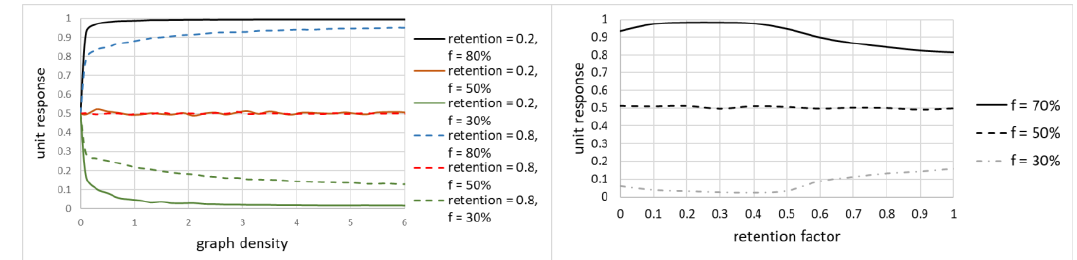
Figure 3. Unit response as a function of graph density ( left ) and retention factor ( right ).